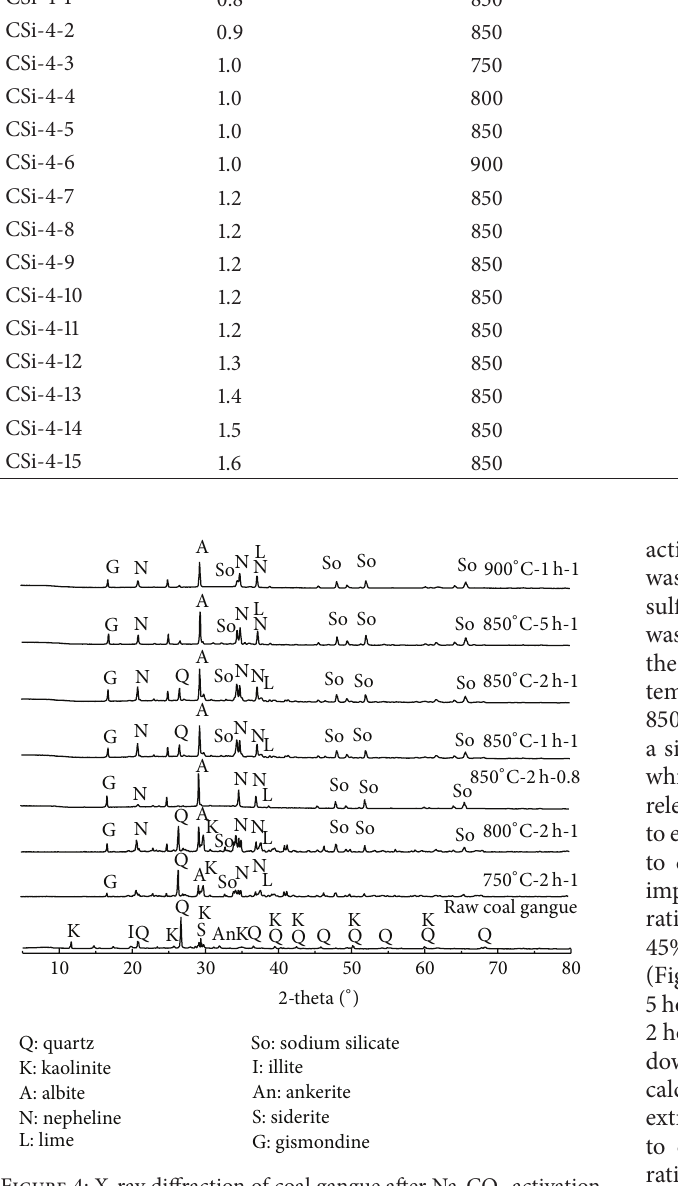
(CaMg(CO 3 ) 2 ), siderite (FeCO 3 ), and gismondine (Ca(Al 2 Si 3 O 10 ) ⋅ 3H 2